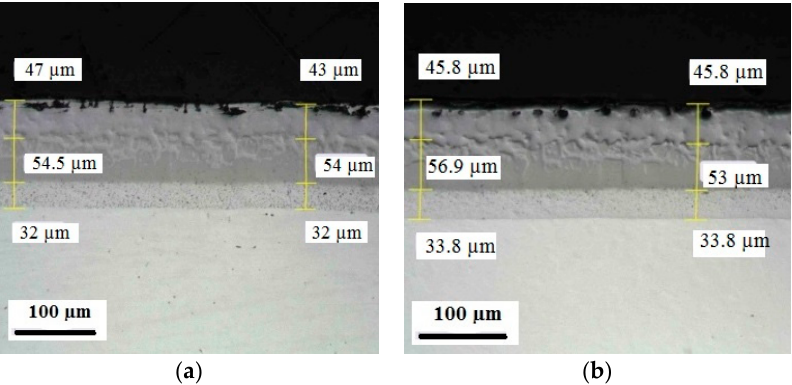
Figure A13. Microscopic images of the cross-section of 316-A-Z ( a ) before and ( b ) after the low-temperature corrosive attack after 168 h.